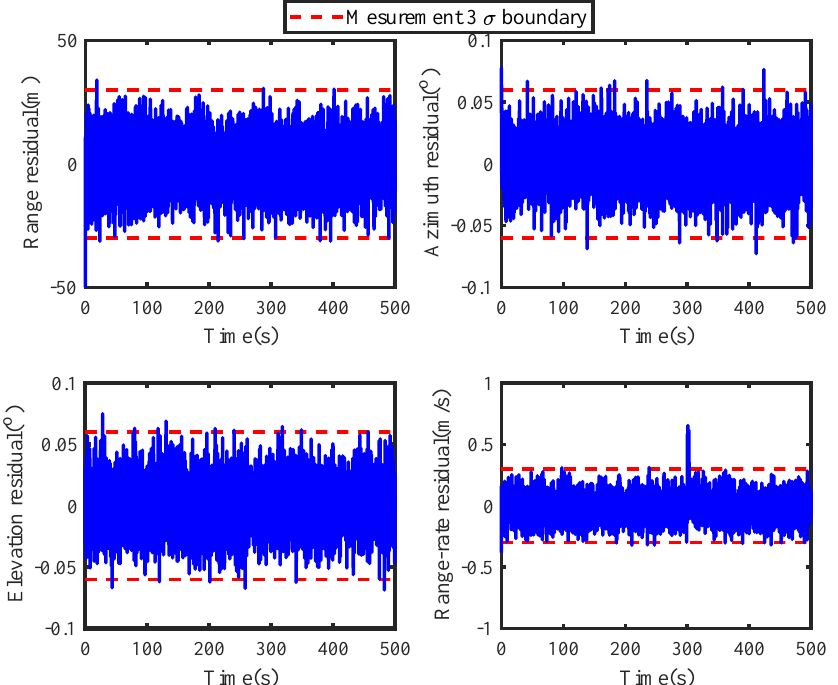
Figure 8. Measurement Residuals of the AWSTUKF. The fading factors of the two methods in case 2 are shown in Figures 9 and 10. When the fading factor is greater than 1, the filter detects unknown maneuvering. the covariance matrix is amplified by the fading factor. It can be observed that in the TSTUKF method, the fading factor does not change significantly for a small pulse maneuver. For the proposed method, the fading factor exceeds the maneuvering detection threshold at 303 s and the detection delay is 3 s. This comparison shows that the proposed AWSTUKF method can detect the occurrence of unknown maneuvers quicker and more accurately.